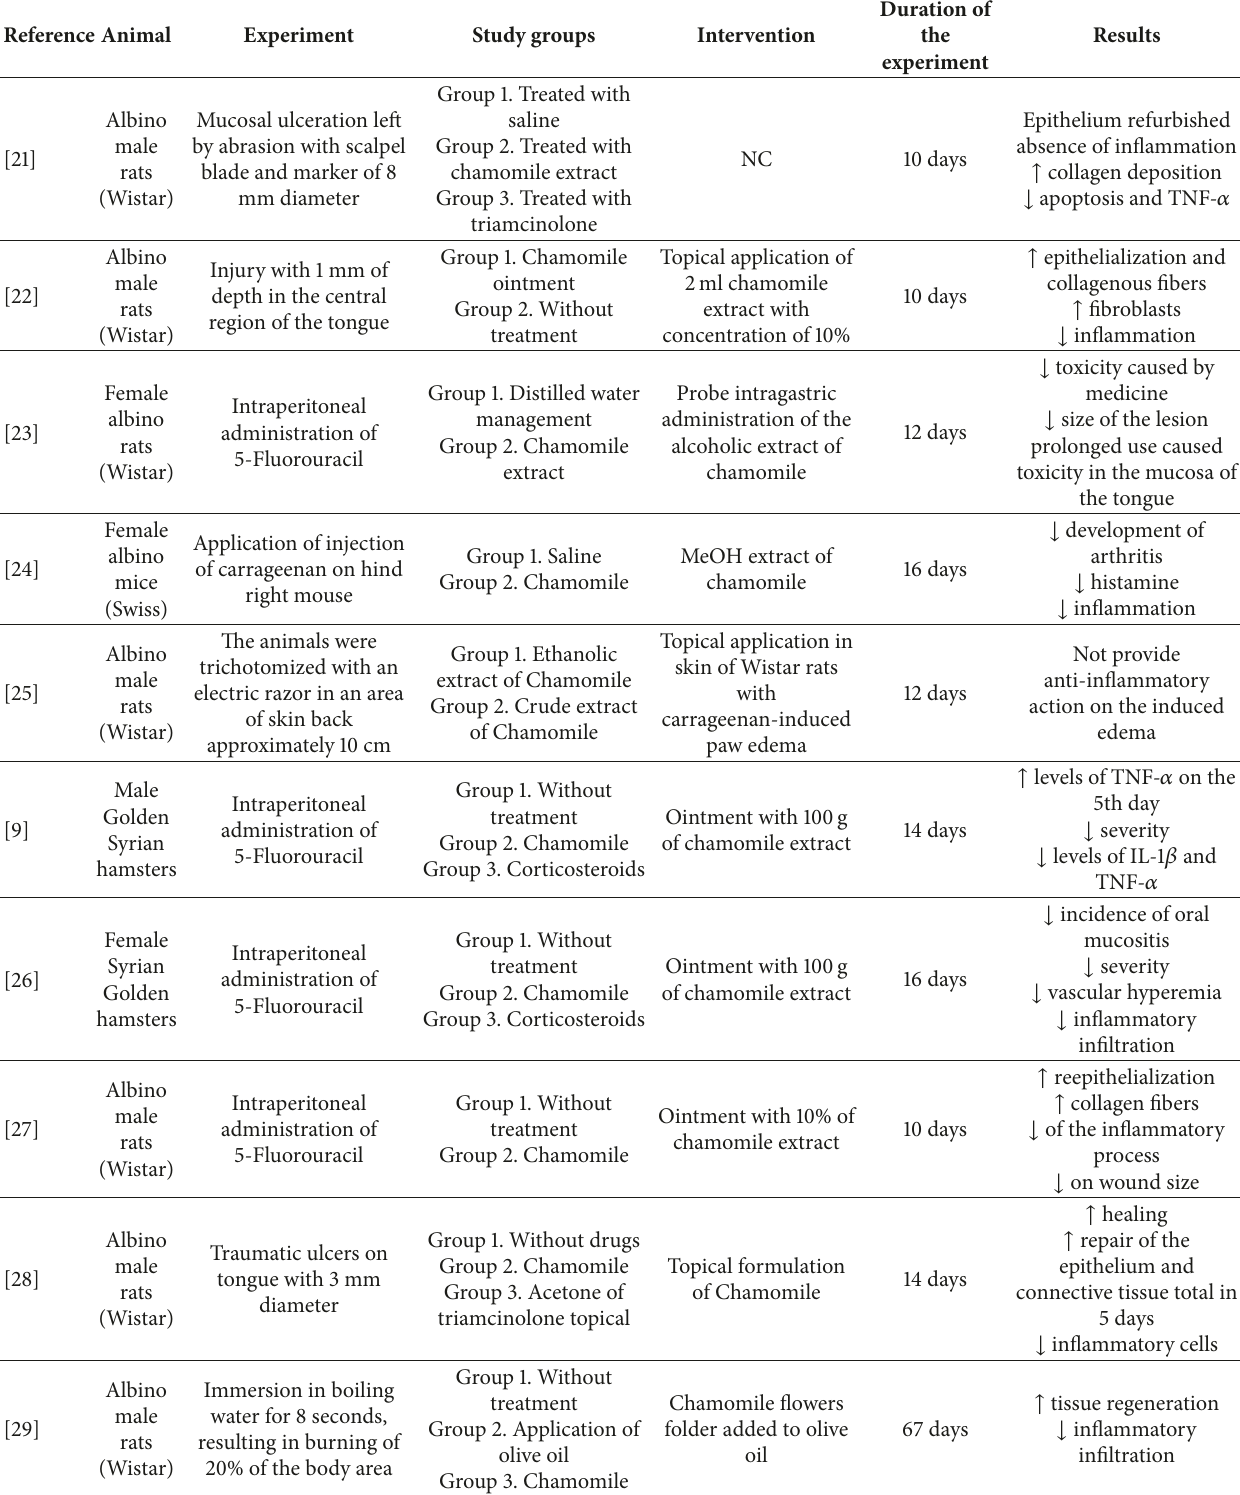
Table 4: Articles included in the review organized in chronological order of publication: authors, animal experiment, study groups, interven- tion, duration of the experiment, and